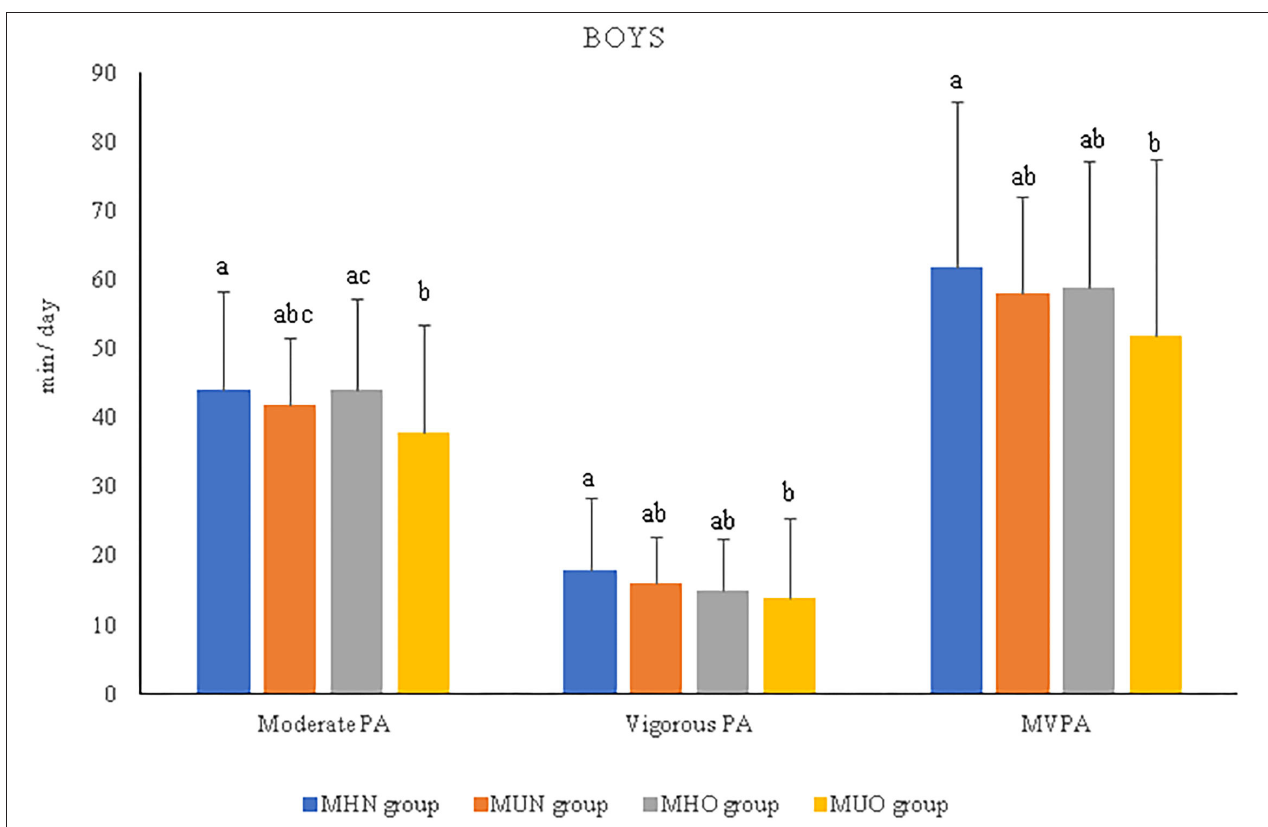
FIGURE 2 | Relevant results of physical activity intensities and duration per day in prepubertal boys according to metabolically healthy or unhealthy status, normal weight or overweight/obesity. MHN, metabolically healthy normal weight group; MUN, metabolic unhealthy normal weight group; MHO, metabolically healthy overweight/obesity group; MUO, metabolic unhealthy overweight/obesity group; PA, physical activity; MVPA, moderate-to-vigorous physical activity. The p- values were obtained two-way ANOVA or Kruskal–Wallis test. Non-matching superscript letters ( a , b , or c ) indicate significant differences ( p < 0.05) by pairwise post-hoc tests adjusted for age to determine differences between experimental